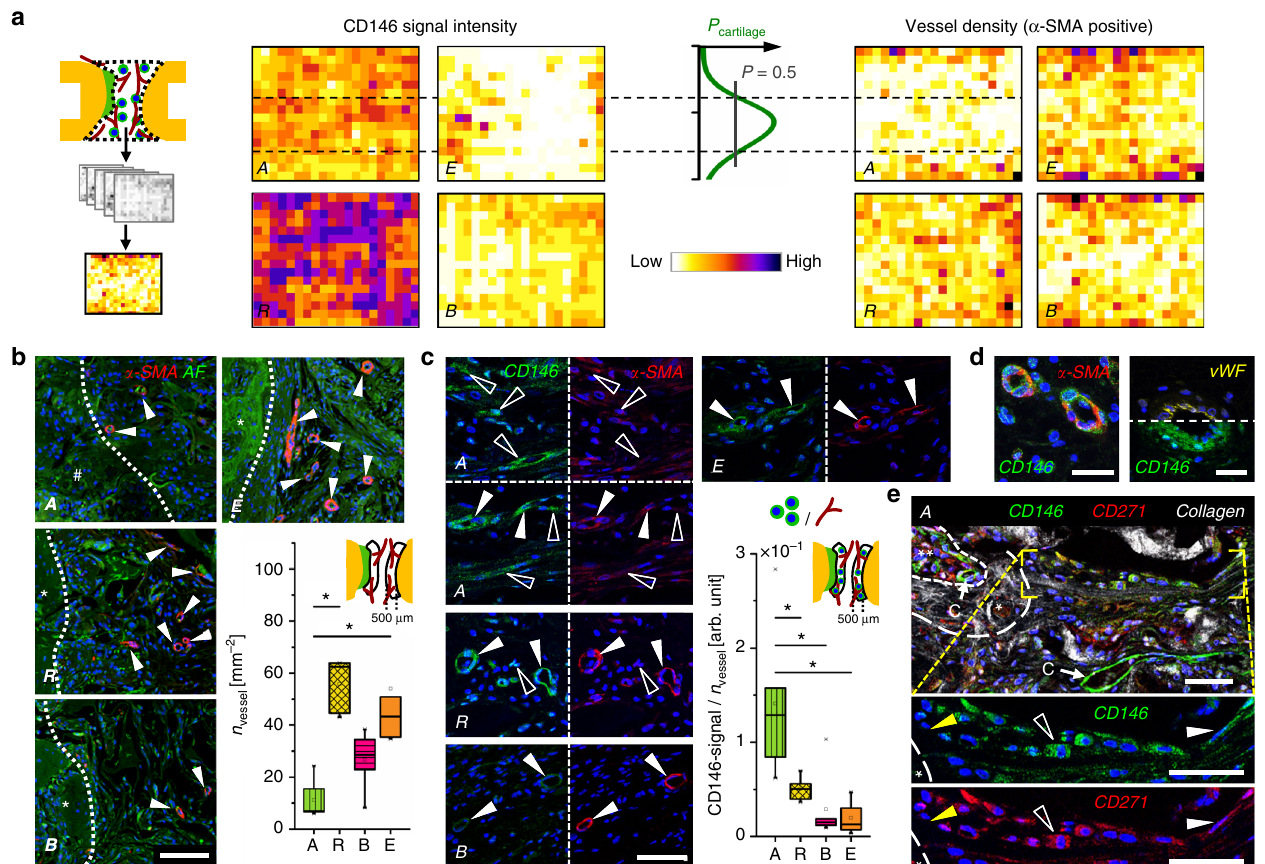
Fig. 7 High progenitor cell number and low vessel density constitute the environment for EO. a Heatmaps show distribution of CD146 signal and α -SMA- positive vessel density as mean values of all animals for groups A, R, B, and E. The probability to fi nd cartilage in scaffold A was highest in the region with low number of vessels and high number of CD146 + cells (region of P cartilage > 50%), see also Supplementary Fig. 10. b Immunohistological staining for α - SMA (red), cell nuclei (blue), and auto fl uorescence (AF) signal (green) at the interface between cartilage (group A, hash symbol) or mineralized tissue (groups R,B,E, asterisk) and non-mineralized tissue. Boxplot shows quanti fi cation of α -SMA-positive vessels 3 weeks post-op in a ROI of 500 µ m from the interface. c Immunohistological staining for CD146 (green) and α -SMA (red) close to the interface showing CD146 signal around vessels, but also associated with individual elongated cells for group A (open arrowheads), bright CD146 signal around vessels for group R (full arrowheads), and lower CD146 signal around vessels for group B and E. Boxplot shows the ratio between CD146 signal and vessel density 3 weeks post-op in a ROI of 500 µ m from the interface. d CD146 and α -SMA signal were both perivascular but did not colocalize. CD146 signal was detected outside the endothelium stained by von Willebrand Factor (vWF) in consecutive sections, verifying the speci fi city of CD146 staining. e CD146 + cells were found to be involved in the process of EO. Magni fi cations show cells in the pre-cartilage region (full white arrowheads) and in the cartilage region (open arrowheads) expressing CD146 but also CD271. CD146 signal was also found around capillaries (C) in the pre-chondrogenic region and in the bone marrow (double asterisk). Bone marrow was enframed by mineralized tissue rich in collagen (asterisk). All boxplots show the median, 25th, and 75th percentile values (horizontal bar, bottom, and top bounds of the box), whiskers indicate 1.5-fold IQR, open squares indicate means, crosses represent max./min. values. Signi fi cances via Mann – Whitney test (two-sided) with Bonferroni correction for b , c ; * p < 0.05. n = 5 – 7 animals per group for a , b , c . Scale bars for b 100 µ m, c , d 50 µ m, e 25 µ